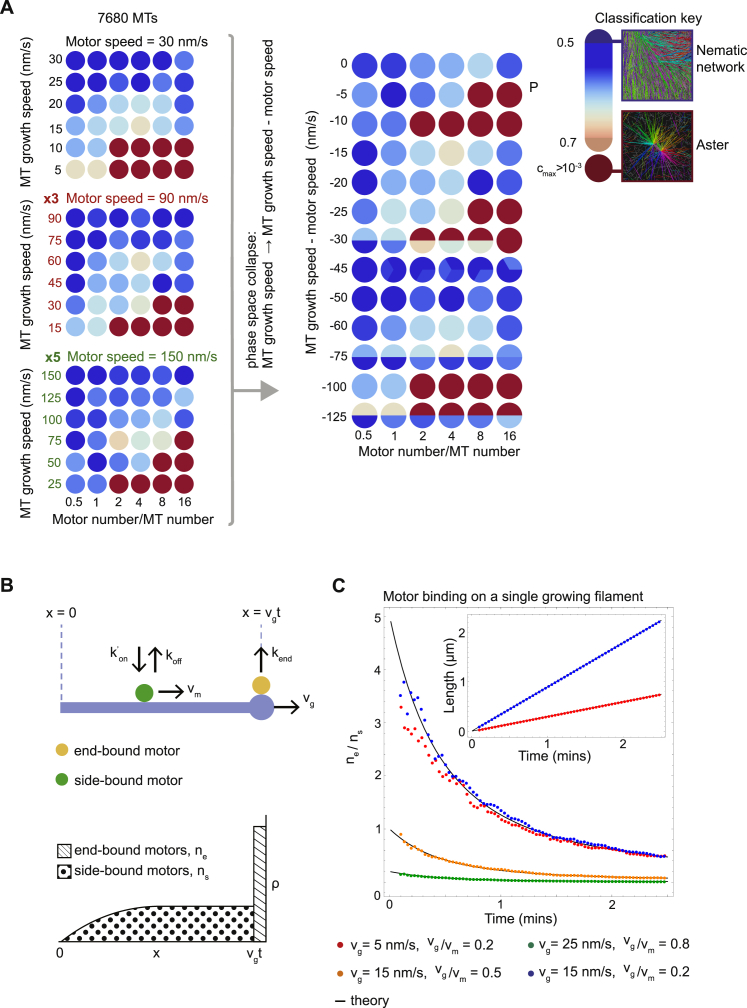
The Ratio of Motor Speed vm to Microtubule Growth Speed vg Determines the Ratio of End-Bound Motors to Side-Bound Motors on a Single Microtubule, Related to Figure 5(A) Failed attempt to collapse the three phase spaces in Figure 5C plotting here the difference in motor speed and growth speed against motor number per microtubule. Different colors indicate different types of network according to the classification key shown on the right (STAR Methods). Where simulations are coincident in the collapsed phase space the circle is divided between them. y axis is not shown to scale. Compare with the successful phase space collapse using the ratio of motor speed and growth speed in Figure 5D. (B) (Top) Schematic representation of the single filament model showing binding and unbinding kinetics of a motor on a microtubule. Binding and unbinding of motors from the side of the microtubule occurs at rates k’on and koff respectively. Motors move deterministically at speed vm to the plus-end that is growing at speed vg. Motors unbind from the plus-end at rate kend. (Bottom) Example motor density profile. Dotted area represents the total number of motors on the side, ns, and lined area represents the total number of motors at the plus-end, ne. (C) Time evolution of the ratio of end-bound motors to side-bound motors on a single growing microtubule for different pairs of parameters vm and vg. Colored points represent average results from 4 simulations (see Table S1 for parameter values) and black lines correspond to theory (Equation S5). Inset shows the average length of the microtubules over the same period for two parameter sets. For the same ratio but different magnitudes of vm and vg (red circles, blue crosses), the ratio of side-bound to end-bound motors will be the same at a given time point in the microtubule’s lifetime, although the lengths of the microtubules will differ at this time. This provides a mechanistic explanation as to why the ratio of motor speed to microtubule growth speed is a control parameter in our model; it captures the spatial distribution of motor crosslinks on microtubules.